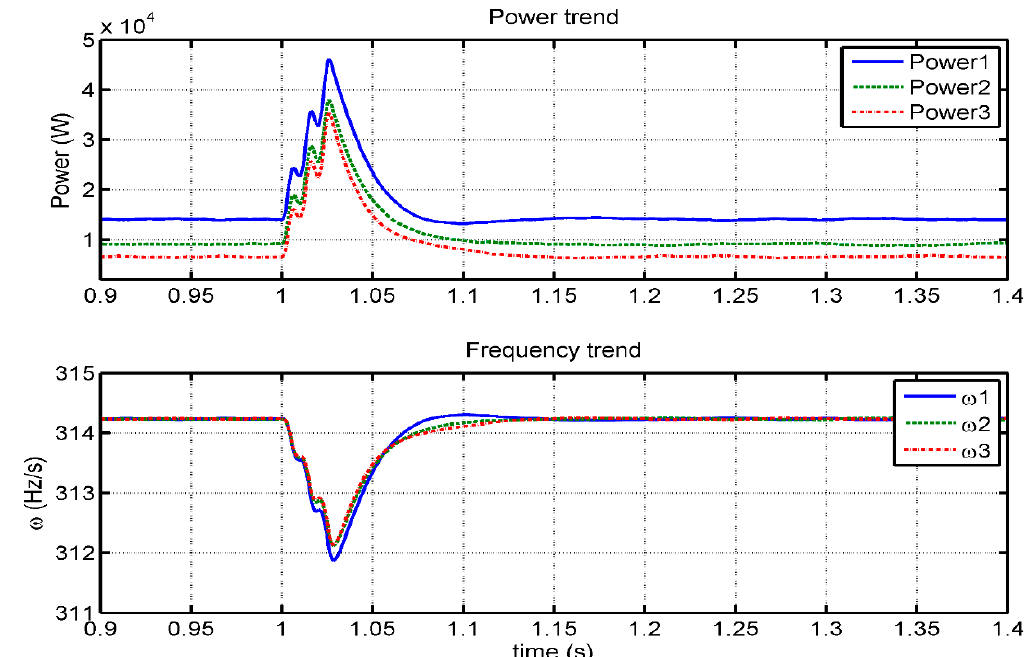
Figure 19. Fault Analysis Case I. Figure 19 . Fault Analysis Case I. Figure 19 . Fault Analysis Case I.